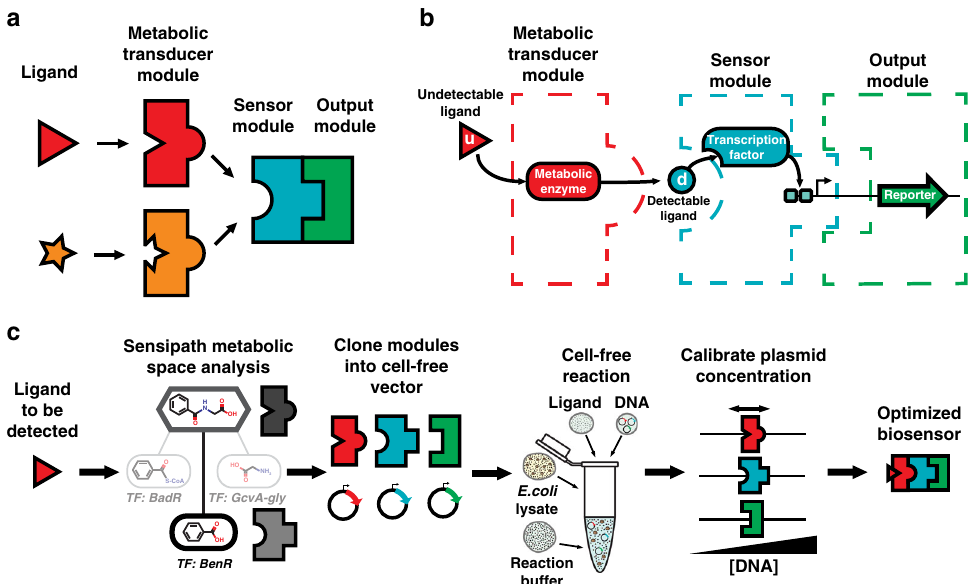
Fig. 1 A modular design work fl ow for engineering scalable cell-free biosensors. a Cell-free biosensors are composed of three modules: a generic sensor module linked to an output module and a metabolic transducer module transforming different molecules into ligands detectable by the sensor module. b An undetectable ligand is converted into a detectable ligand by the enzyme from the transducer module. Binding to the transcription factor controls the sensor module and downstream gene expression. c The biosensor design work fl ow starts with retrosynthetic pathway design using the SensiPath server 19 . Once the transducer and sensor modules are determined, the genes encoding enzymes, transcription factors, and target promoters driving a reporter are cloned into cell-free expression vectors. The sensor is calibrated by titrating the concentrations of each plasmid to maximize signal output and dynamic range